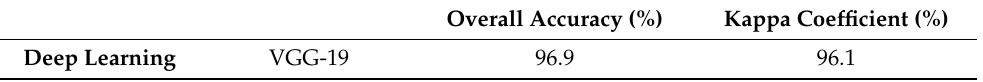
Figure 9. The VGG-19 CNN classification map. Table 4. Overall accuracies and kappa coefficients for the deep learning method.